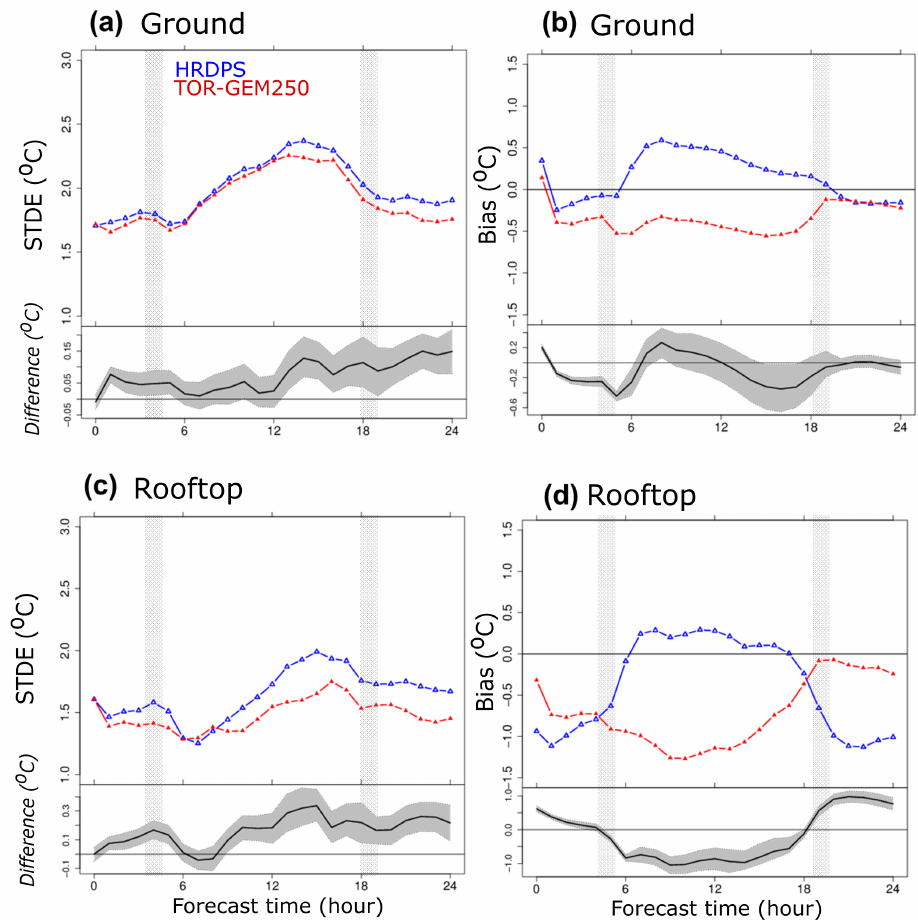
Figure 12. Mean diurnal cycle of temperature errors (starting at 0200 EDT) for TOR-GEM250 (red) and HRDPS (blue) statistical performance (STDE, ( a , c ) and Bias, ( b , d )), for the near-surface air temperature T 2.5 m (in °C) for measurement sensors above the ground ( a , b ) and above rooftops ( c , d ). Vertical shaded areas highlight sunrise and sunset occurrence for the period 13 May–31 August 2015. Bottom plots represent the net comparison of TOR-GEM250 over HRDPS with the shading representing 5–95% confidence interval from the bootstrapping method (positive values indicate an improvement with